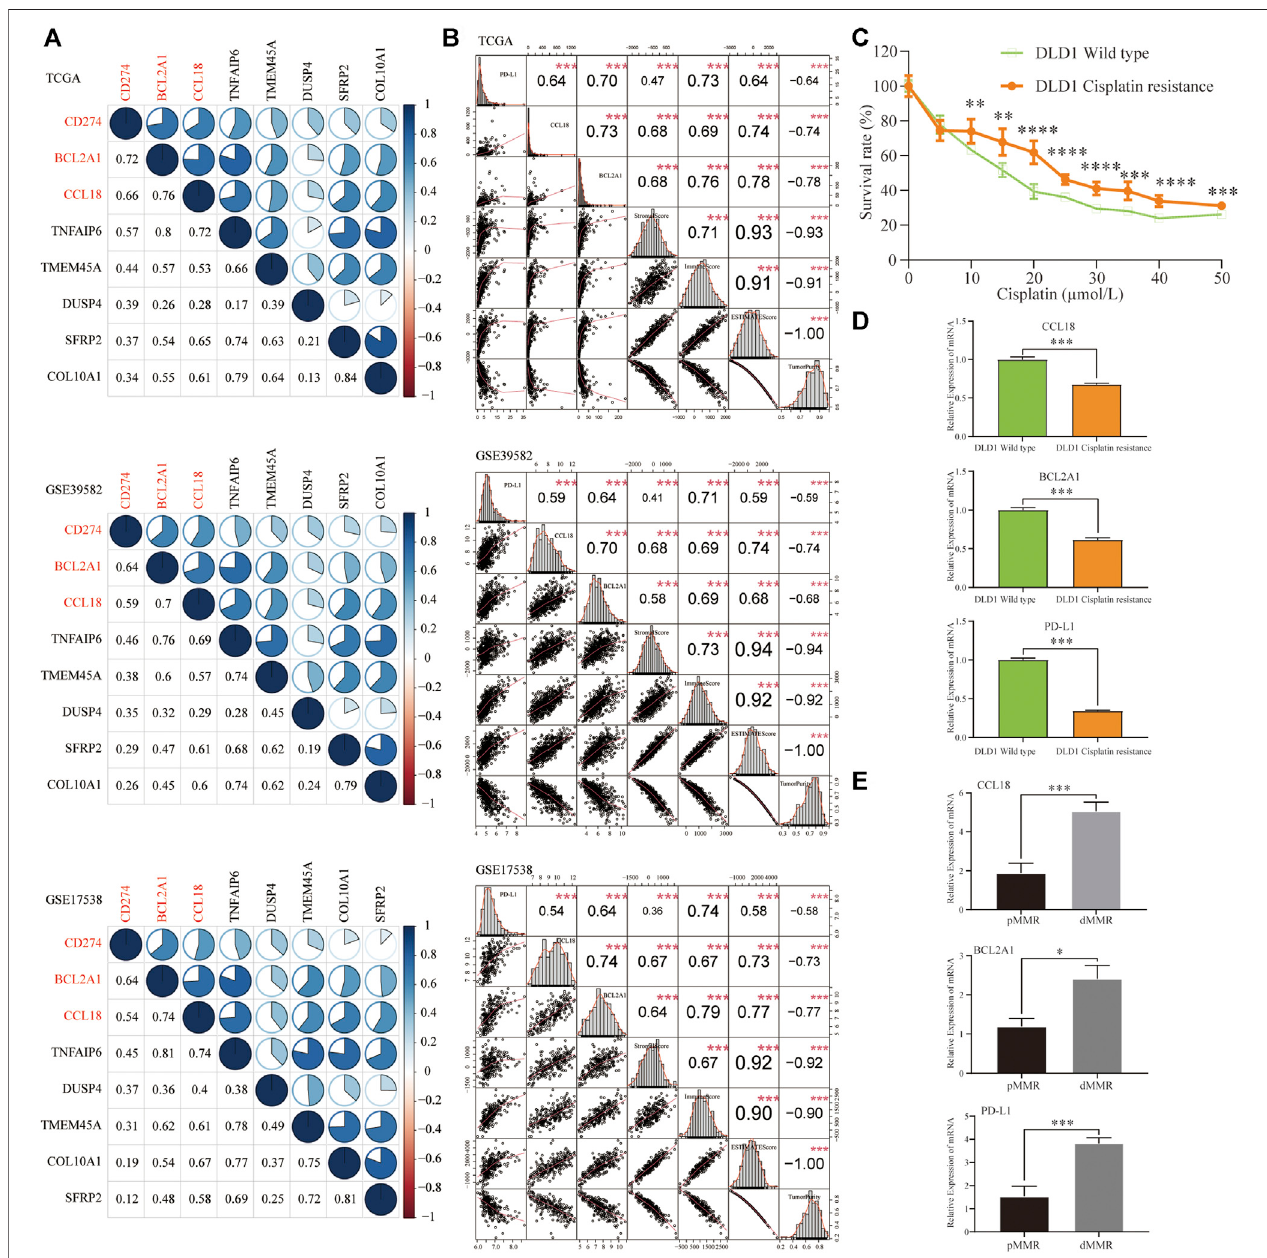
FIGURE6 | Correlation ofseven resistance-related genes with PD-L1 expression, theTME scores, tumor purity, and in vitro validation. In three COAD cohorts, (A) CCL18andBCL2A1hadahighercorrelation withPD-L1(Spearman ’ scorrelationcoef fi cient > 0.5) (B) SimilartoPD-L1,CCL18andBCL2A1weresigni fi cantlypositively correlatedwithstromal,immune,andESTIMATEscoresandsigni fi cantlynegativelycorrelatedwithtumorpurity.Incisplatin-resistantDLD1cellline (C) ,similartoPD-L1, CCL18andBCL2A1weresigni fi cantlydownregulated (D) . (E) ComparedwithpMMRtissues,themRNAexpressionofCCL18,BCL2A1andPD-L1indMMRwas signi fi cantly increased. ** p < .01, *** p < .001, **** p < .0001.